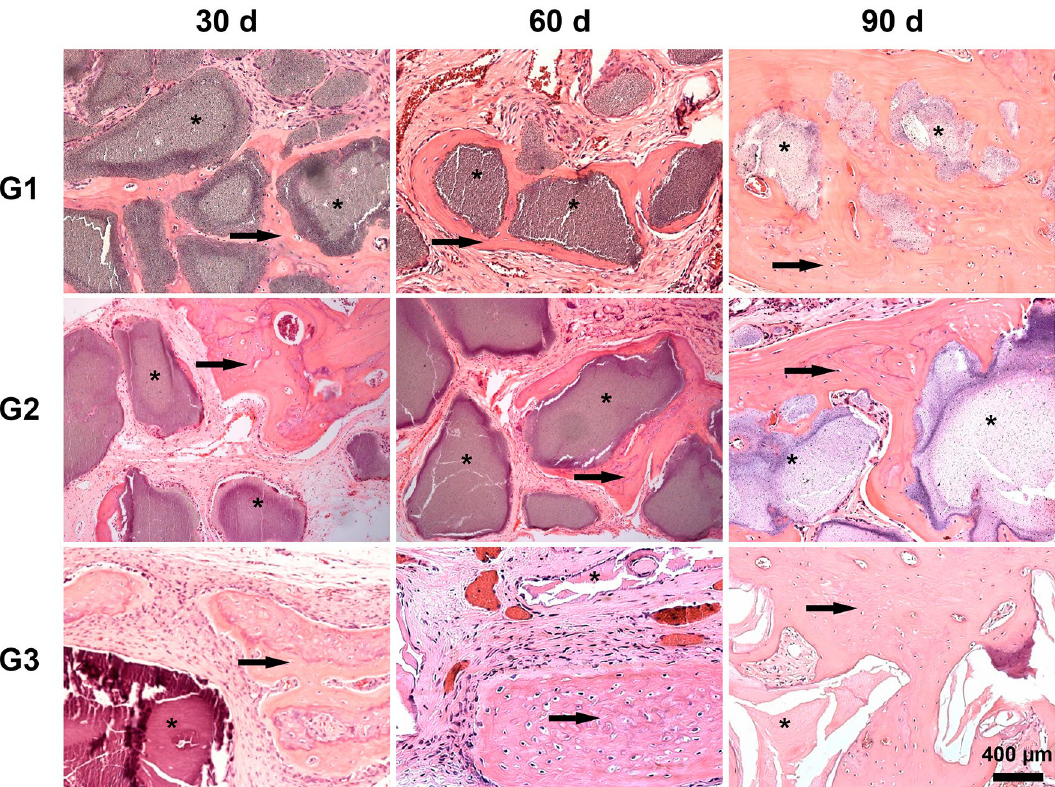
Figure 2. Representative images of histological sections stained with hematoxylin and eosin from the areas of critical-sized bone defects filled with biphasic materials G1 (Nanosynt 250 to 500 μm), G2 (Nanosynt 500 to 1000 μm), and xenogeneic G3 (Bio-Oss 200 to 1000 μm) at 30, 60 and 90 days. At 90 days, a mature lamellar bone was observed, and bone ingrowth occurred both on the biphasic material surfaces and inside its particles. Detailed images showing the presence of remaining biomaterials (*) within the implantation bed, and lamellar bone formation ( → ). Bar = 400